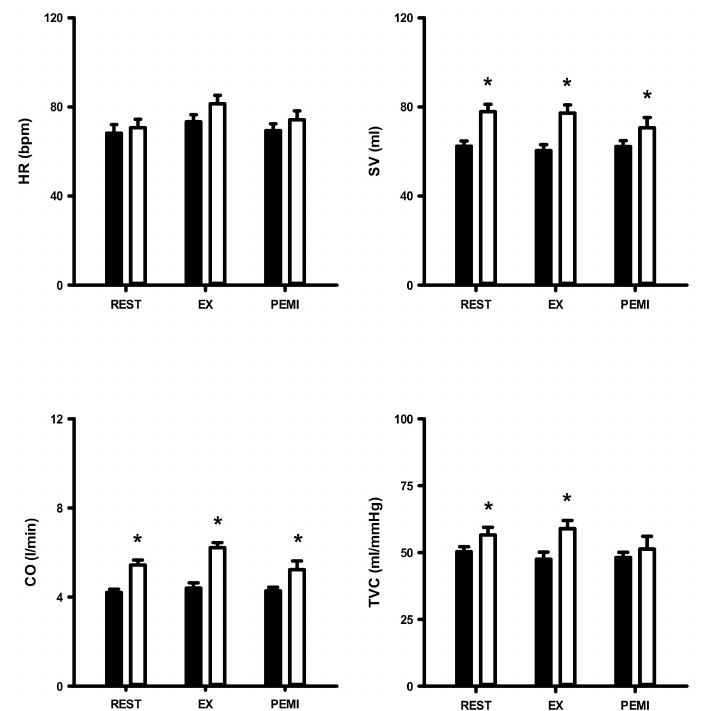
Figure 3. Heart rate (HR), stroke volume (SV), cardiac output (CO), and total vascular conductance (TVC) during dynamic exercise and post-exercise muscular ischemia (PEMI) in normal and obese individuals. Black bar, normal; open bar, obese. * p < 0.05, vs. normal individuals.